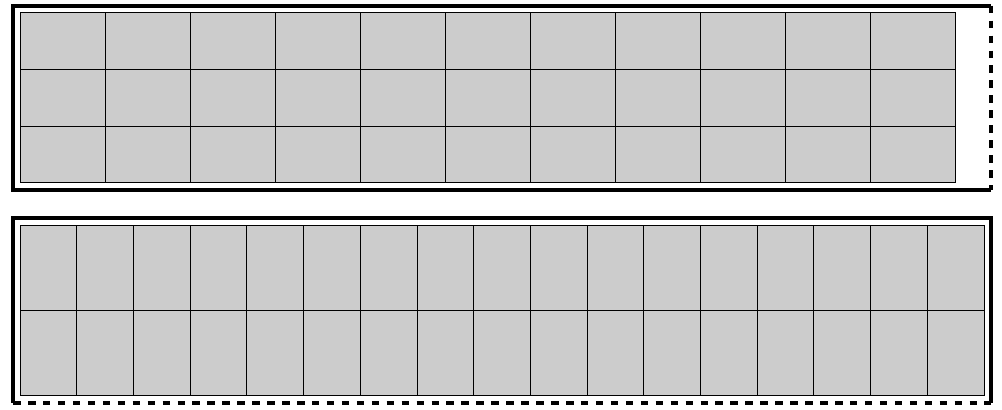
Figure 1. Top: a 45-foot container loaded from the back with three rows of 11 pallets each, resulting in a problem with R = 3 and L = 11. Bottom: a 45-foot container loaded from the side with two rows of 17 pallets each, resulting in a problem with R = 17 and L =